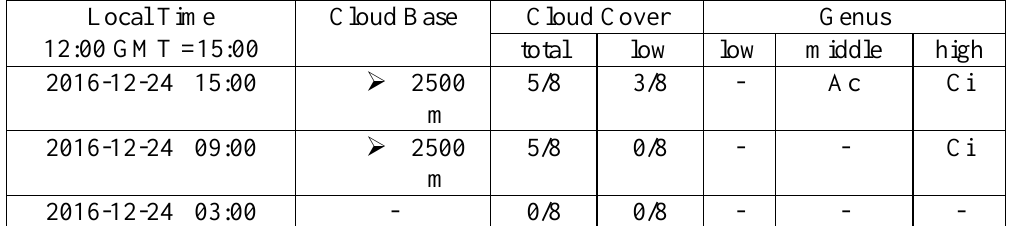
Table 9: Surface weather forecast for Basra.